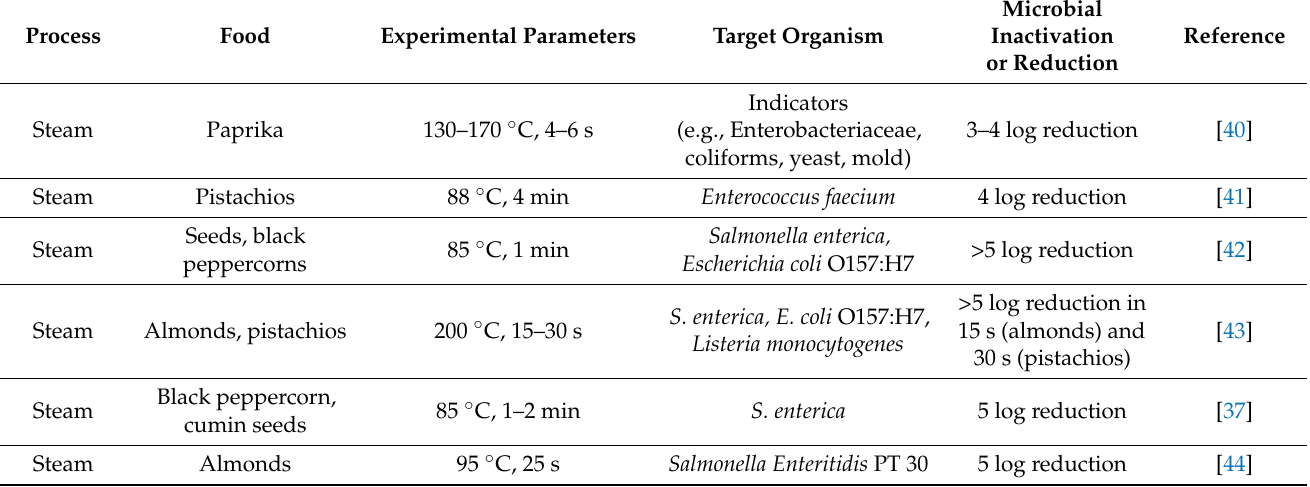
Table 1. Effect of pasteurization treatments on different microorganisms in human food. Adapted from